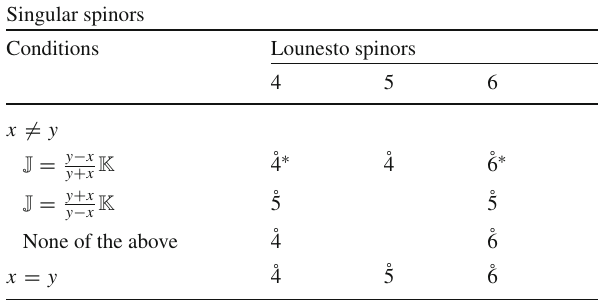
Table 3 Correspondence between singular